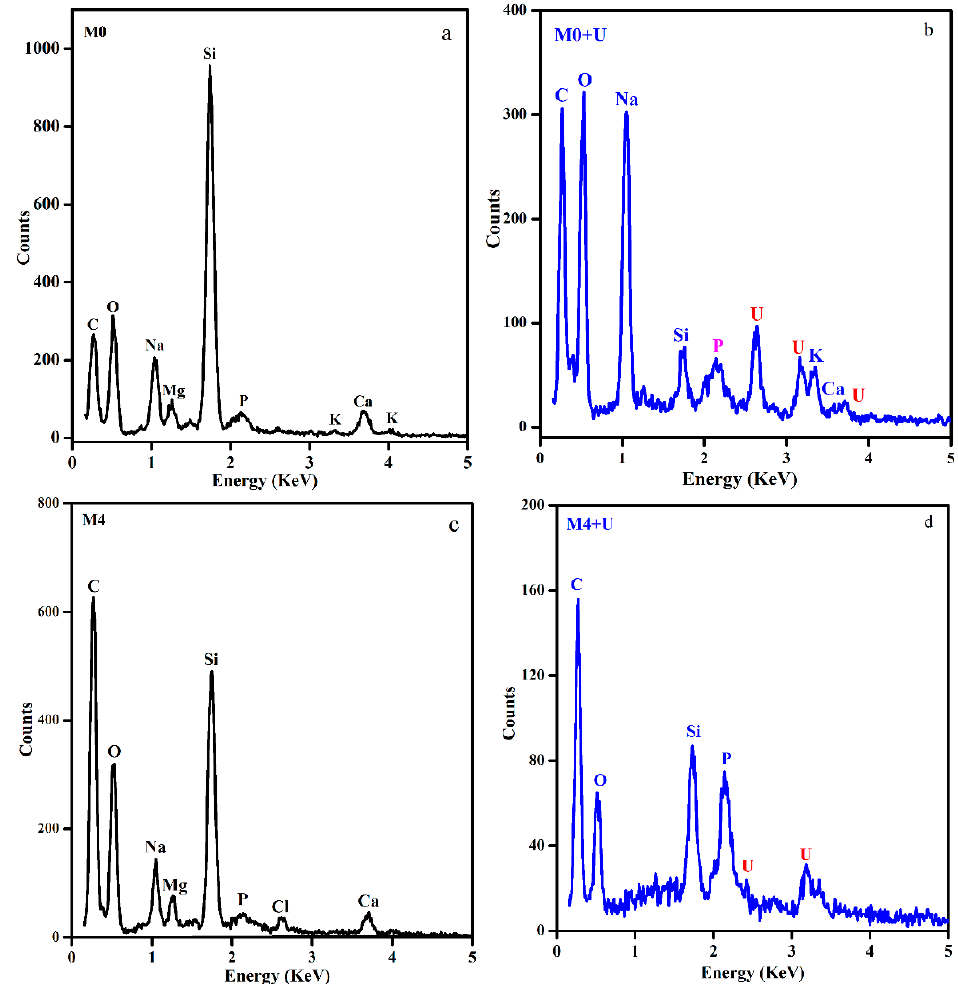
Figure 7. EDS micrographs of the biomass of Deinococcus radiodurans before and after biosorption of uranium. ( a ) Unmodified biomass before adsorption. ( b ) Unmodified biomass after biosorption. ( c ) Biomass of phosphate esterification. ( d ) Biomass of phosphate esterification after biosorption.